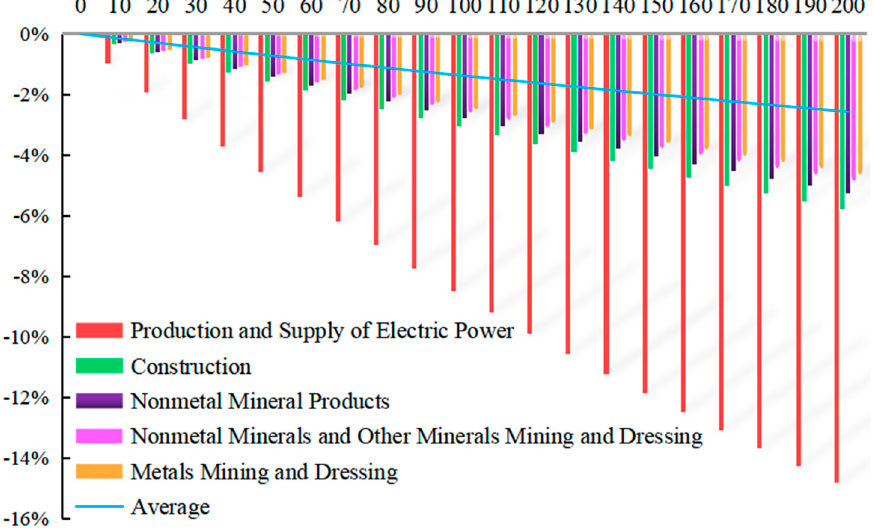
Figure 7. Impact of different rates of carbon tax on the changes of the industrial carbon dioxide emission.